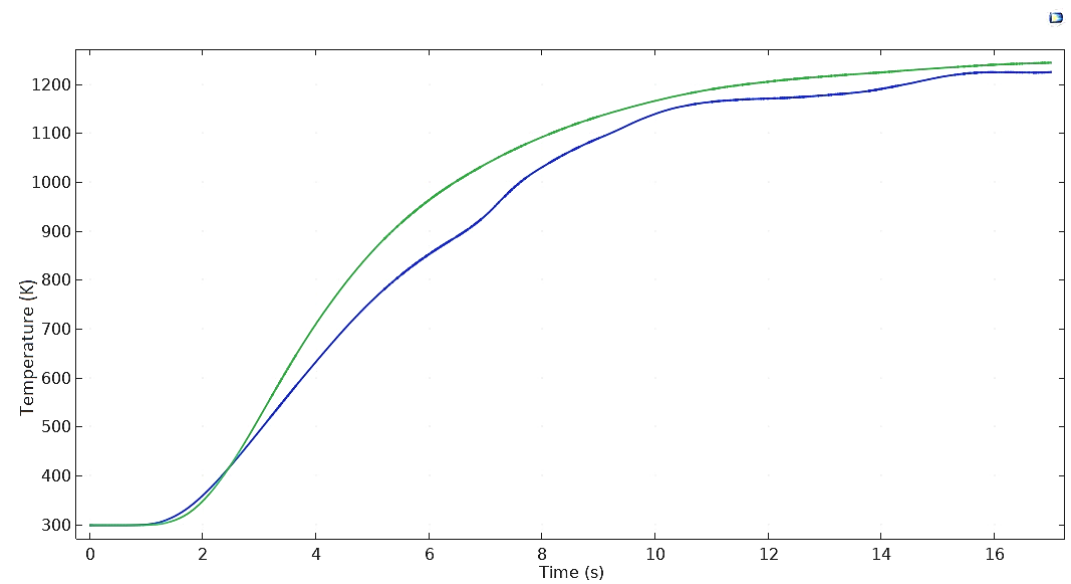
Figure 15. Maximum temperature (transient) of edge probes x = 0 mm (green) and x = 20 mm (blue).